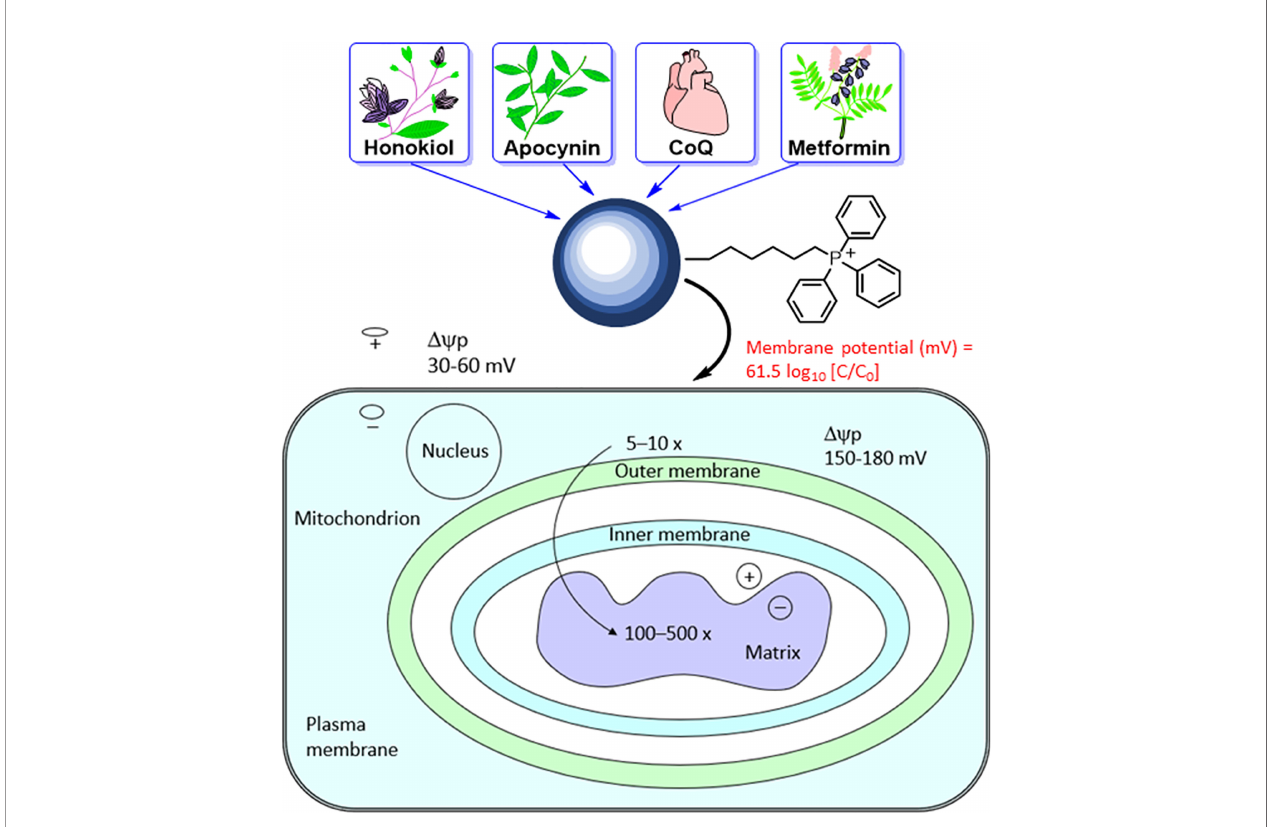
FIGURE 4 | Mitochondrial uptake of TPP + -containing drugs and natural products into cancer cells due to enhanced hyperpolarization. The top portion of this fi gure is reprinted (adapted) with permission from Zielonka J, Joseph J, Sikora A, Hardy M, Ouari O, Vasquez-Vivar J, Cheng G, Lopez M, Kalyanaraman B Mitochondria- Targeted Triphenylphosphonium-Based Compounds: Syntheses, Mechanisms of Action, and Therapeutic and Diagnostic Applications. Chem Rev. 2017 Aug 9;117 (15):10043-10120. Copyright 2017 American Chemical Society. The bottom portion of this fi gure is adapted from Smith RA, Porteous CM, Gane AM, Murphy MP. Delivery of bioactive molecules to mitochondria in vivo . Proc Natl Acad Sci U S A 2003 Apr 29;100(9):5407-12. Copyright 2003 National Academy of